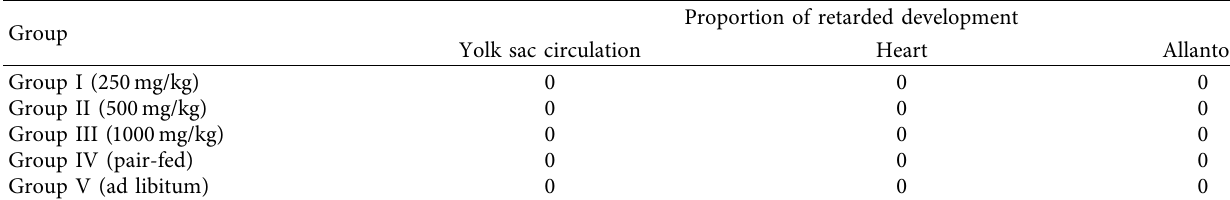
Table 2: Embryonic development developmental indices of the circulatory system after treated with 80% ethanol fruit extract of Embelia schimperi .